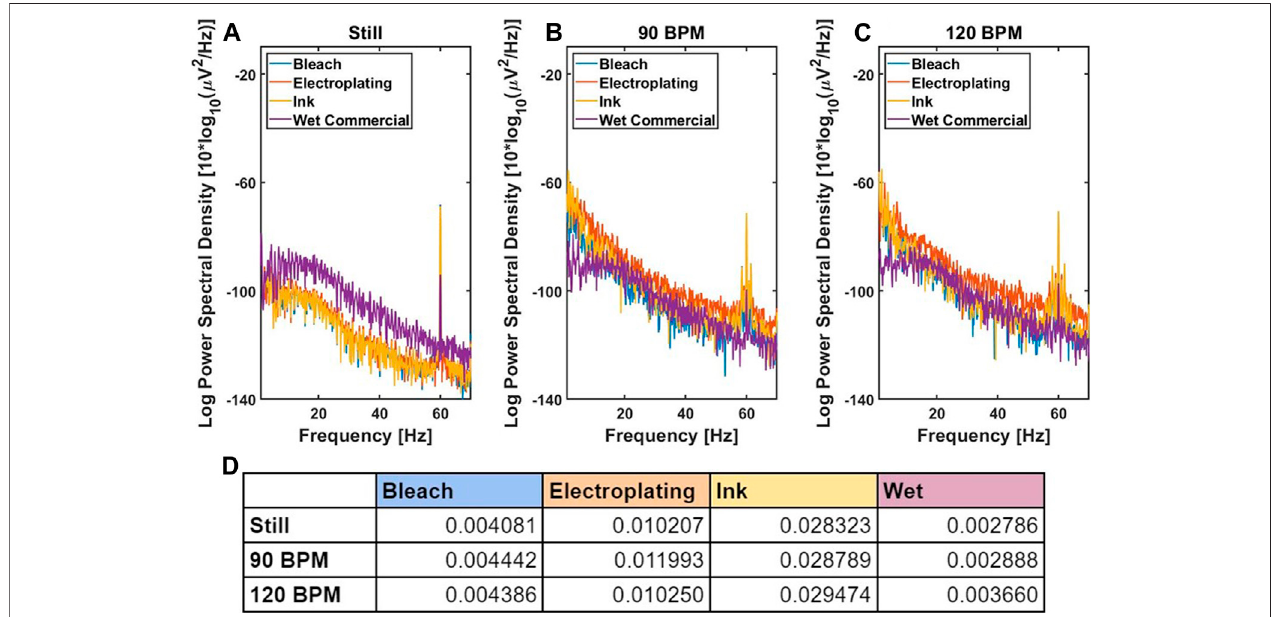
FIGURE 3 | Motion artifact analysis. The average log power spectral density of ECG recordings of still (A) , subject walking in place at 90 BPM (B) , and subject walking in place at 120 BPM (C) . The area underneath the curve of the PSD at units of μ V 2 /Hz from 0 to 20 Hz. The units of the values in this table are μ V.